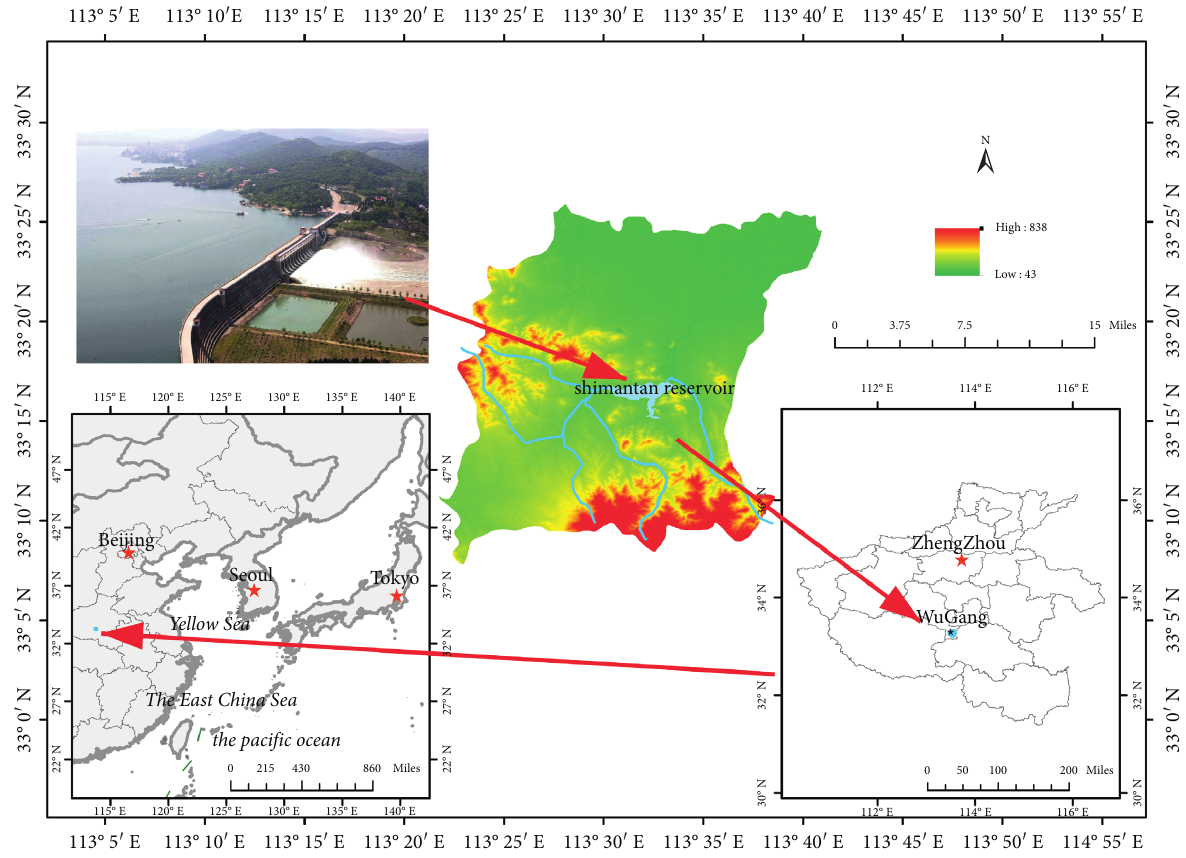
Figure 9: Geographical location of the Shimantan